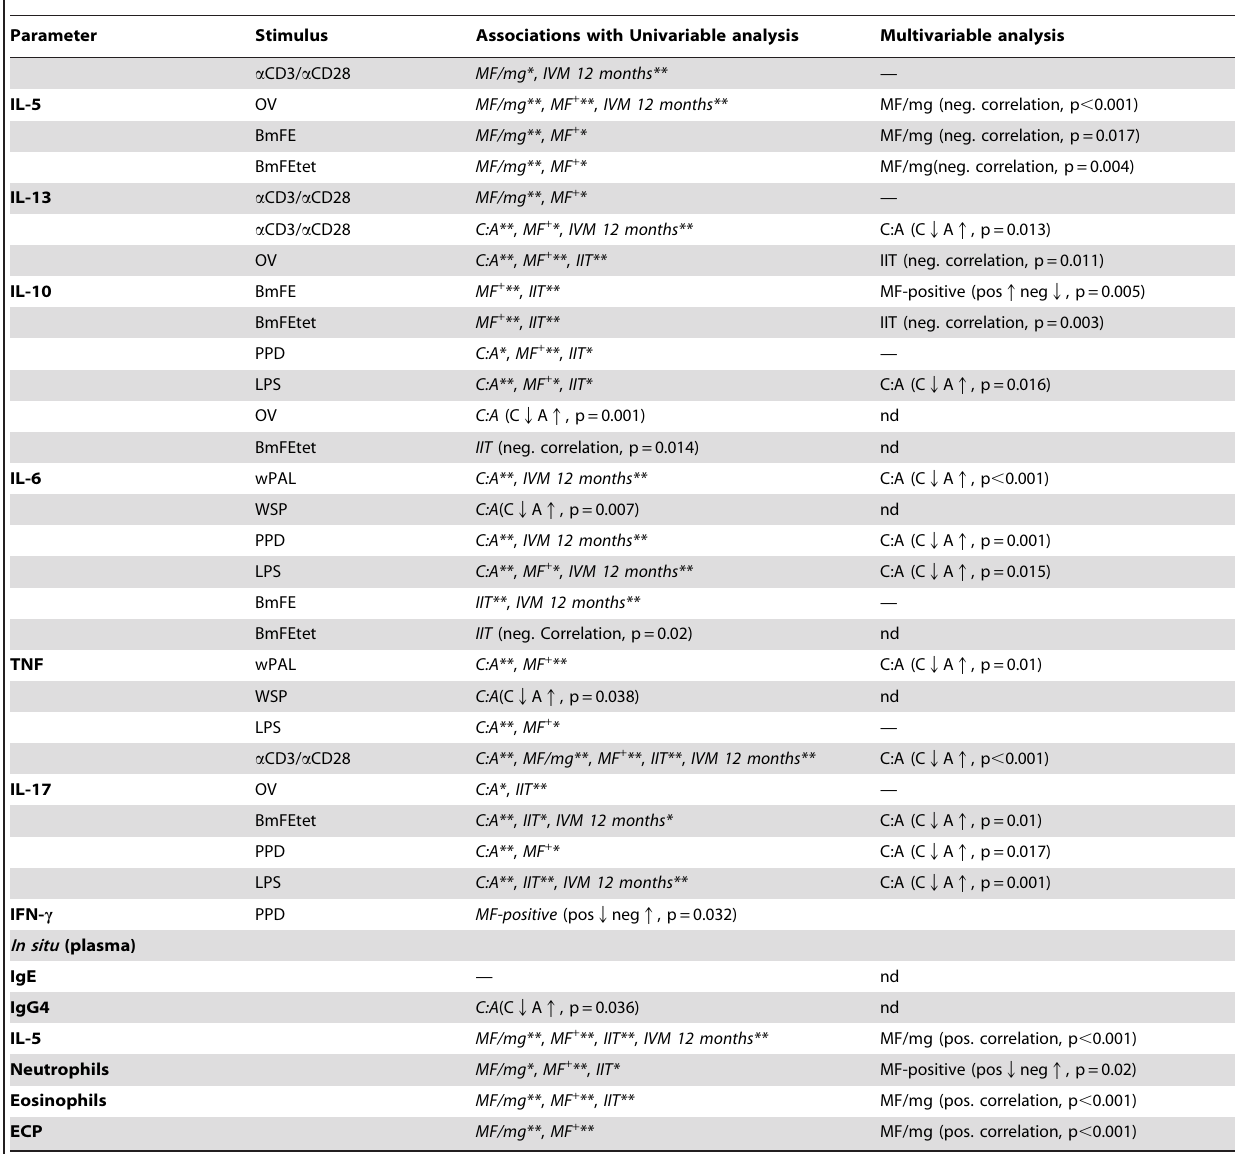
Table 2. Summary of regression analysis between MF + and a-MF